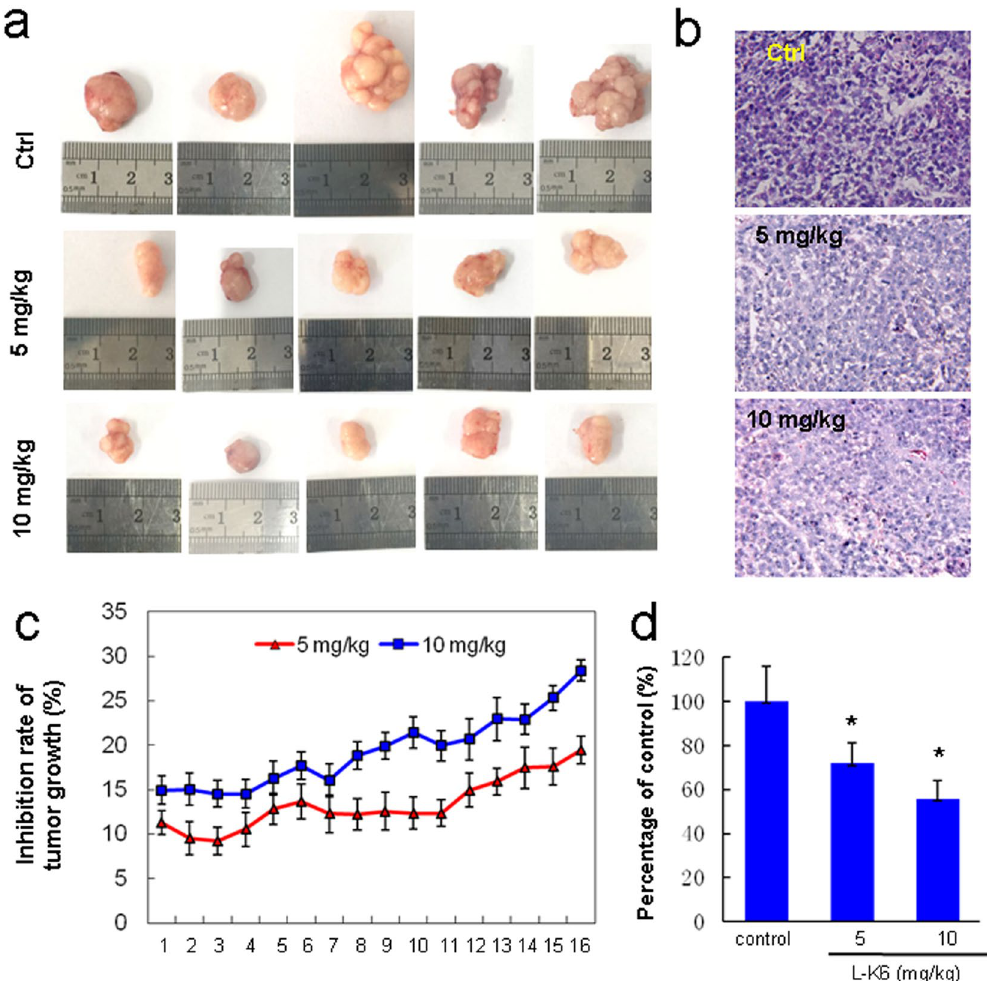
Figure 8. Anticancer activity of L-K6 in vivo . To further confirm the anticancer activity of L-K6 in vivo , nude mice bearing MCF-7 cancer were treated with L-K6 (5 mg/kg, 10 mg/kg) or NS as a control. The tumor size (mean ± SD) was measured everyday ( c ). At the end of the experiment, all animals were sacrificed and the tumor masses were weighed ( a , d ). The pathological analysis was performed by H&E staining ( b ). * p < 0.05 vs. untreated control group (n =